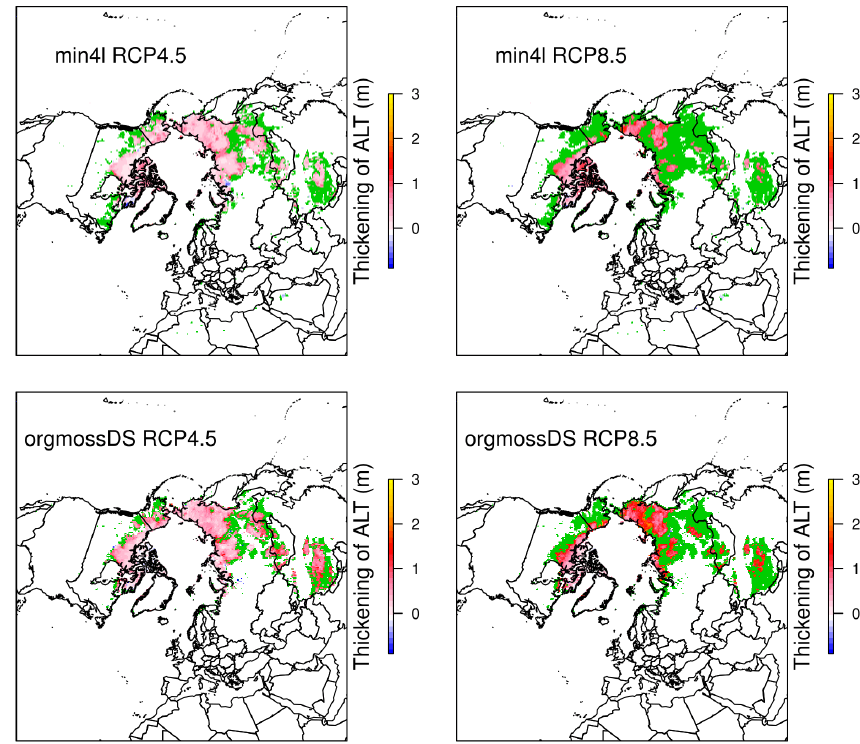
Figure 12. Coloured area shows near-surface permafrost at the start of the simulation: green regions have disappeared by the end of the simulation (2090–2100) and other colours (reddish) show active layer deepening in the remaining